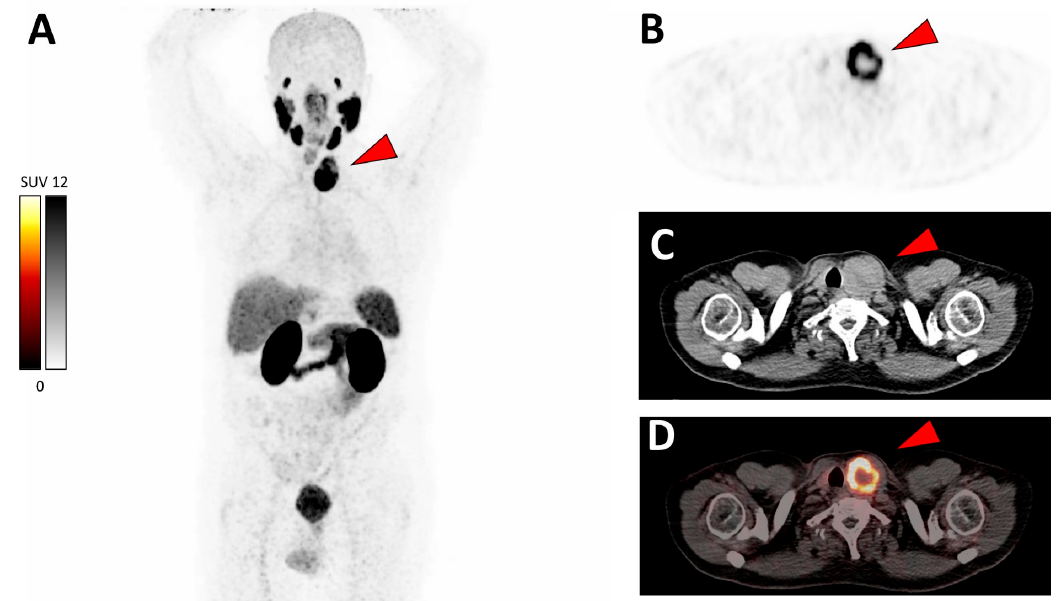
Figure 1. [ 68 Ga]Ga-PSMA-11 PET/CT showing intense uptake (SUV max 32.2) in a left thyroid mass. ( A ) Maximum intensity projection (MIP); transversal slices of ( B ) PET, ( C ) CT, and ( D ) PET/CT fusion. Red arrows point to the left thyroid mass.